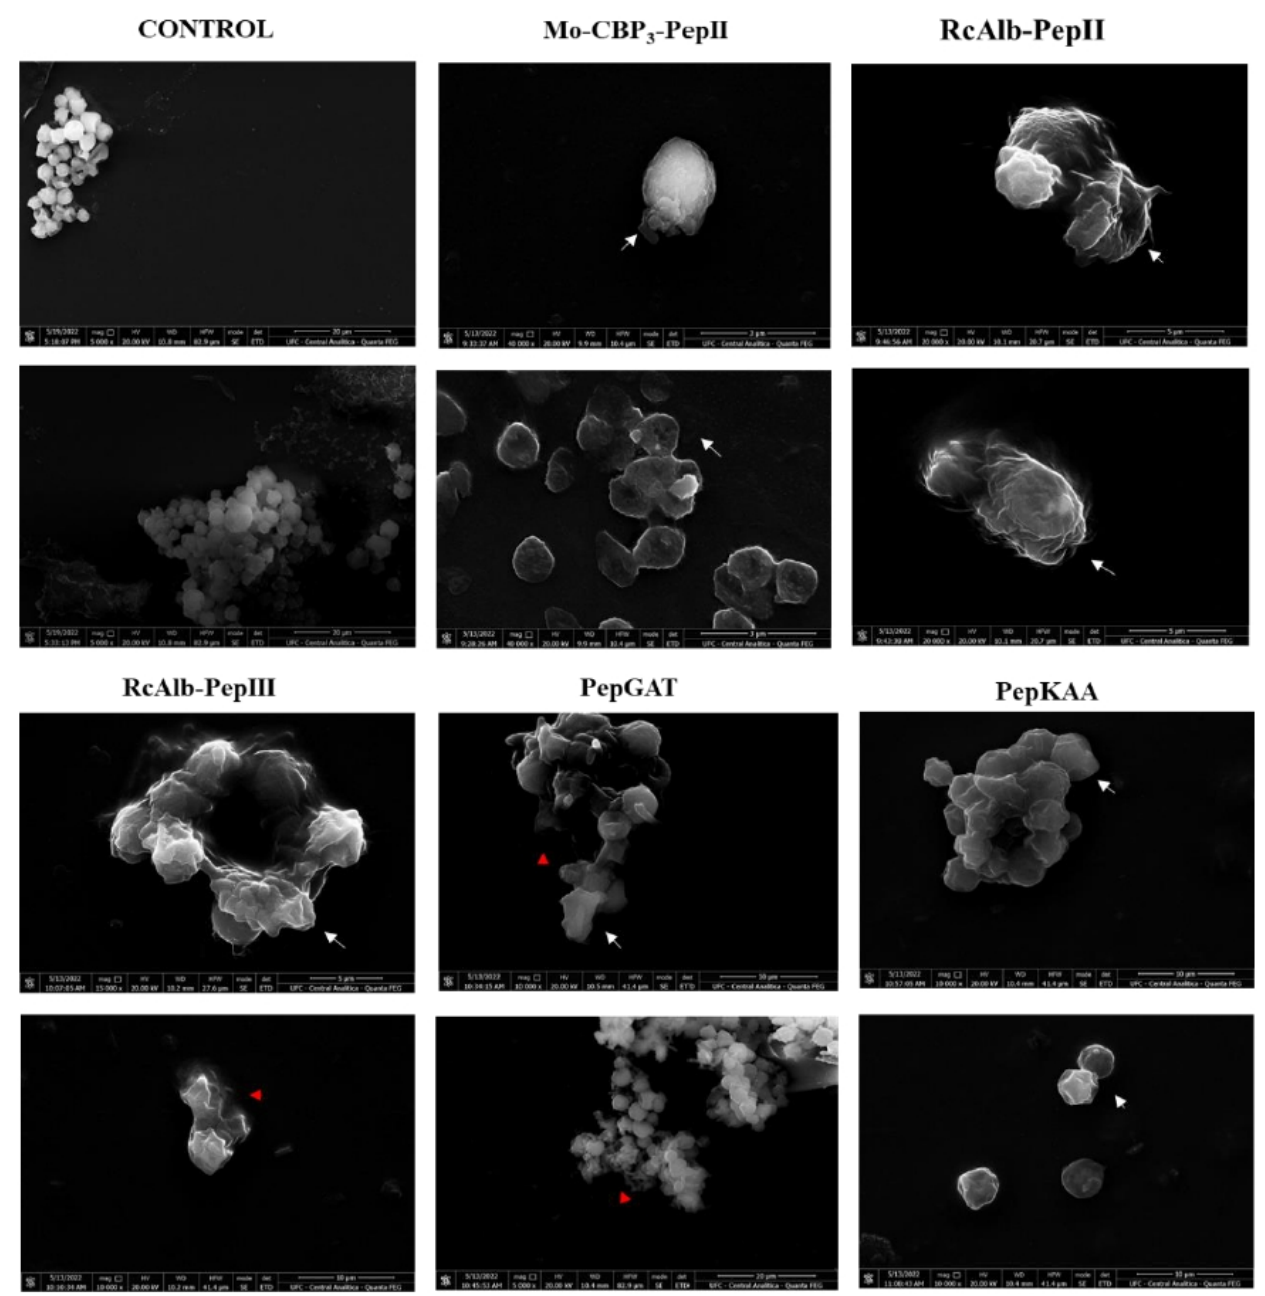
Figure 7. SEM images showing C. neoformans cells after treatment with Mo -CBP 3 -PepII, Rc Alb-PepII, Rc Alb-PepIII, PepGAT, and PepKAA, respectively, at 25, 0.04, 0.04, 0.04, and 0.04 µ g mL − 1 Control: DMSO-NaCl solution. White arrows show damage to cellular structure, and red arrows indicate cytoplasmic leakage.